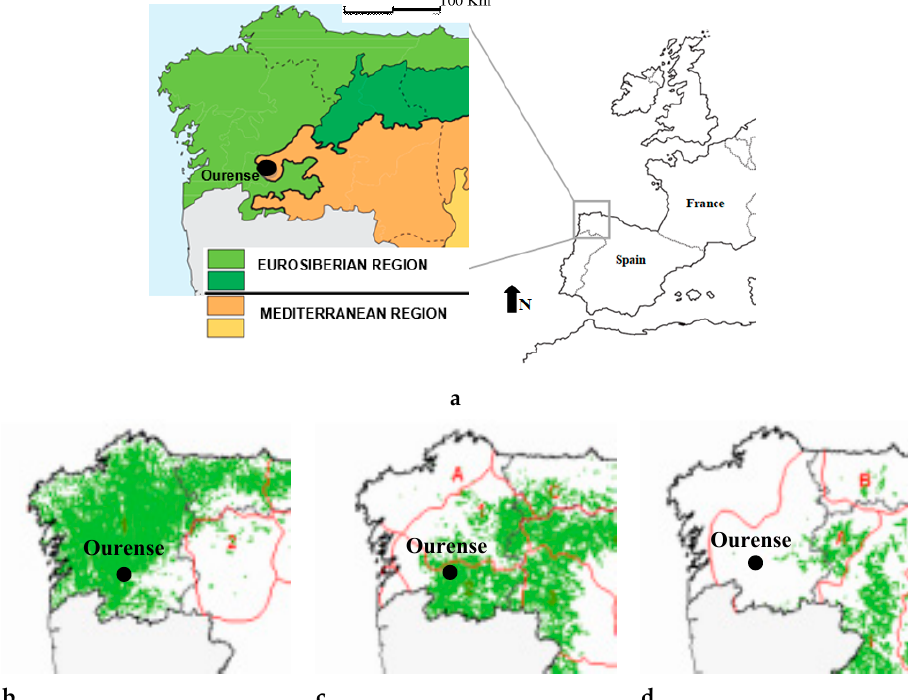
Figure 1. ( a ) Location of the area of study in the North-western of the Iberian Peninsula at the transition zone between the Eurosiberian and Mediterranean Bioclimatic Regions [19] https://www.ign.es/espmap/mapas_ma_eso/MedioESO_Mapa_06.htm. Distribution of the main oak species in the studied area in green: ( b ). Q. robur , ( c ). Q. pyrenaica , ( d ). Q. ilex sub. ballota (http://especiesforestales.com/fichas.html).